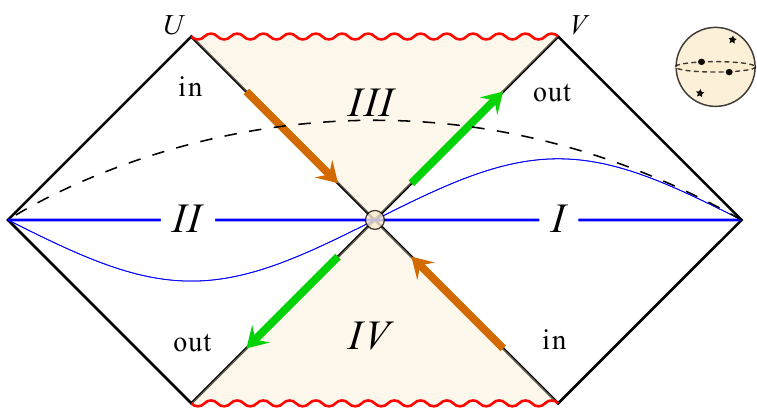
Figure 4 . The Penrose diagram and the antipodal map as originally proposed in [9, 10, 12, 61]. The original t = 0 Cauchy slide that defines the thermofield double is drawn in blue. We depict two possible choices of evolving the slices and quantisation. One is using the Killing vector fields of the geometry with which the Cauchy slices change as shown in the thin blue curve. In contrast, the standard global time evolution involves the slicing drawn with dashed lines. After the antipodal identification, we can remove regions II and IV . The bifurcation S 2 is then antipodally identified as shown in the top right corner. The first type of slices then contain always the complete information for the state of the black hole and pass from the antipodally identified bifurcation two sphere. In the second case instead, a part of the slice is always outside of the